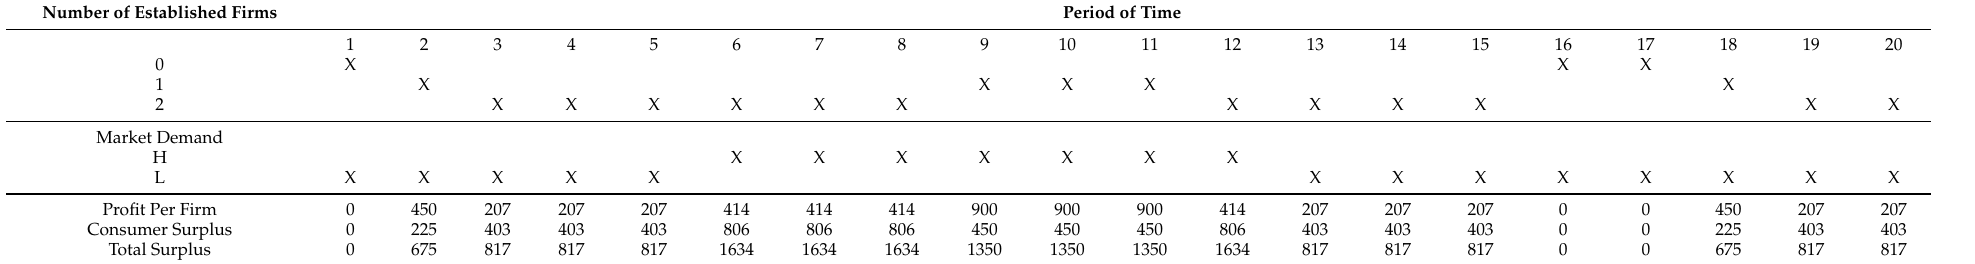
Table 10. Two active firms in the Cournot framework with the initial state of the system ( 0, L ) .